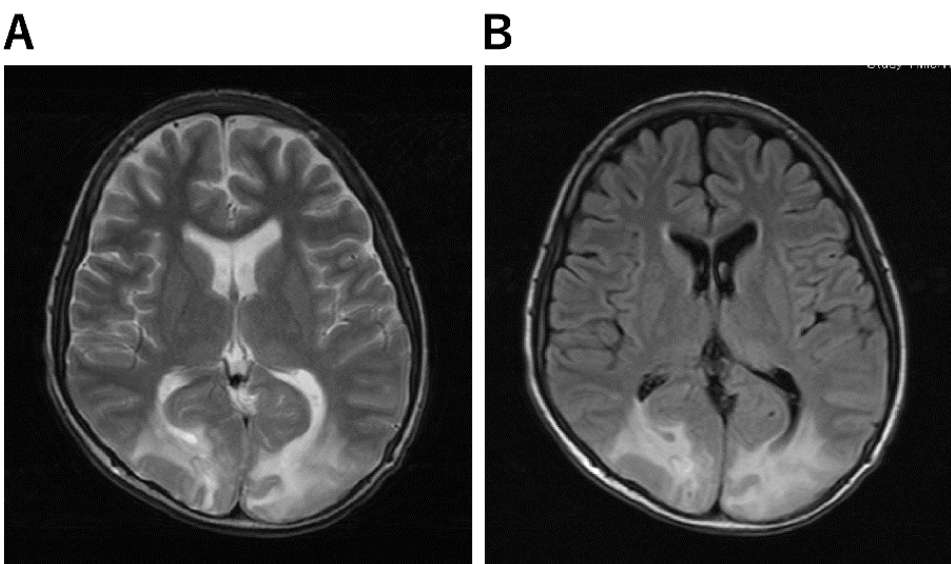
Figure 4. Imaging Characteristics of PRES. ( A , B ): A 13-year-old boy underwent skin graft surgery due to severe burns all over his body. He was on ventilatory management and sedatives for a long period of time postoperatively. As his generalized sepsis improved, his anesthetic was reduced and he was awakened; after 50 days, his consciousness improved completely; on day 51, he complained that “everything I see is white and I can’t see anything.” He then had a severe headache. His blood pressure was 150/89 mmHg and he had hypertension. Brain MRI scan showed an abnormal high signal in bilateral occipital areas on T2-weighted ( A ) and FLAIR ( B ) images, and he was diagnosed with